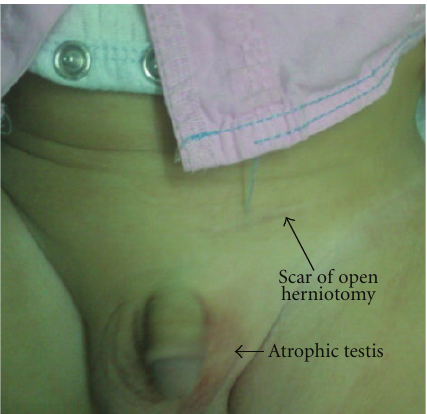
Figure 6: Left testicular atrophy after open